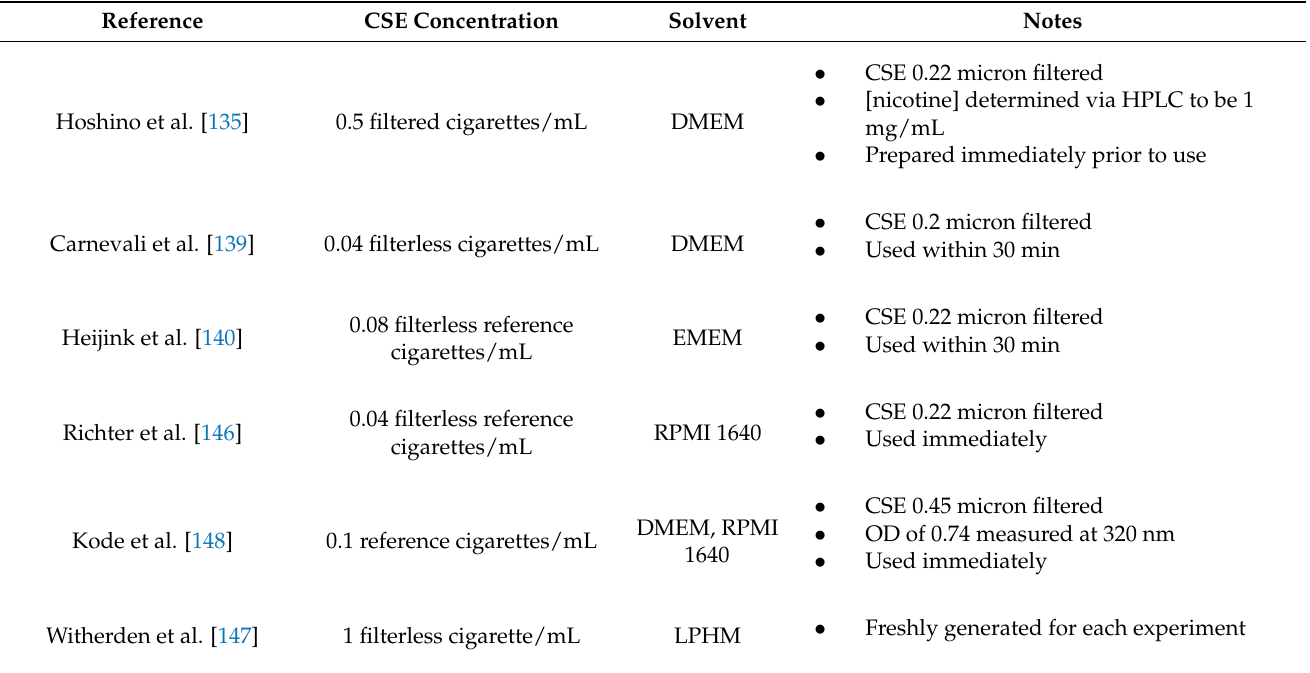
Table 3. Summary of Cigarette Smoke Extract Preparation